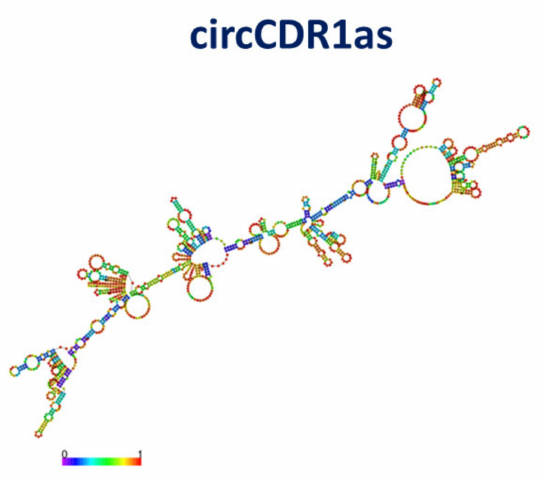
Figure 10. Drawing of the best model for the secondary structure of circCDR1a; colors of the spots indicate the corresponding pair-base probability (see the scale at the